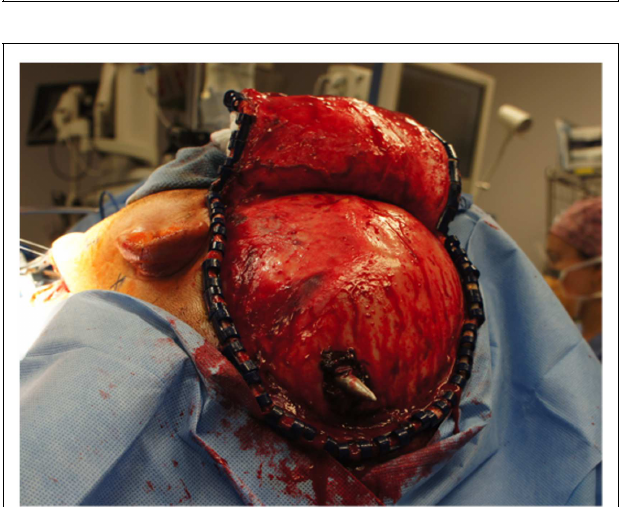
FIGURE 4 |View of the large craniotomy through a left-sided question-mark-shaped trauma flap exposing the foreign object in the posterior parietal region and allowing for a pterional-type approach to the ICA within the intracranial cavity .